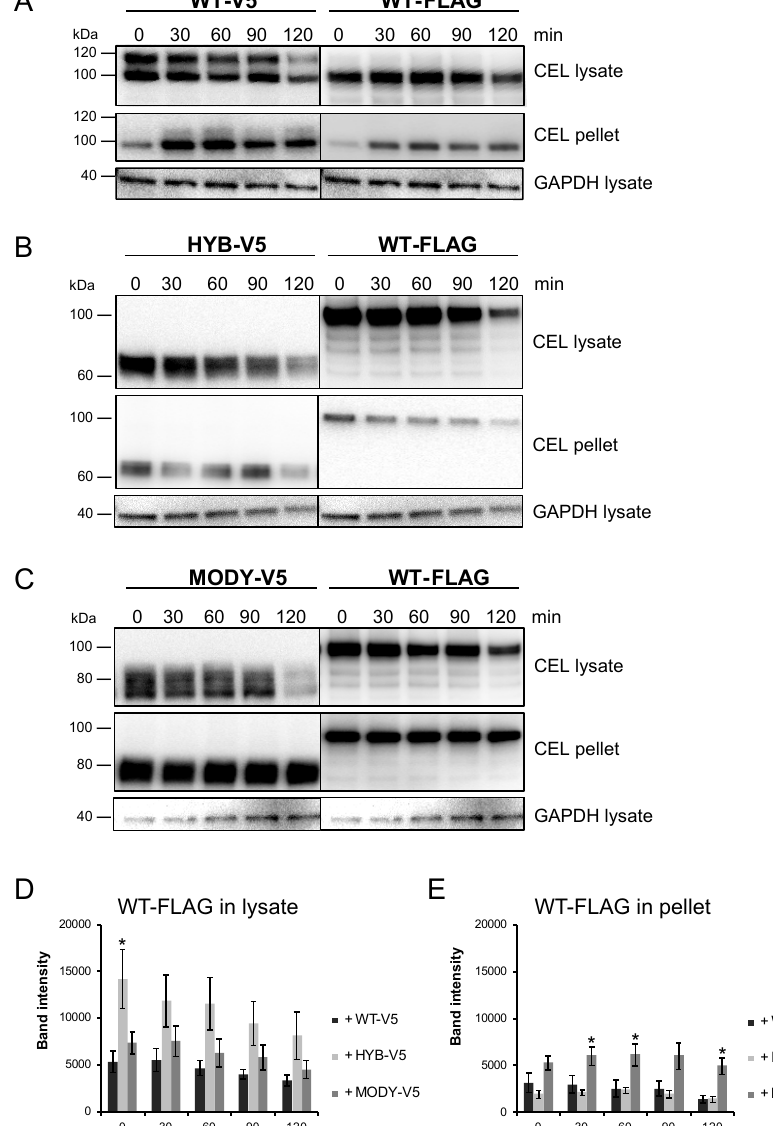
Figure 7. Cellular clearance of normal CEL protein in the presence of pathogenic CEL variants. ( A – C ): HEK293 cells were cotransfected with a FLAG-tagged CEL-WT plasmid and plasmids encoding V5-tagged CEL-WT, CEL-HYB, or CEL-MODY. After 48 h, the cells were treated with 1 µ g / mL cycloheximide for 0, 30, 60, 90, and 120 min. The lysate and pellet fractions were isolated and analyzed by anti-FLAG and anti-V5 tag-specific antibodies. GAPDH in the lysate fraction was used as loading control. ( D , E ): Bands in A–C (WT-FLAG panels) were quantified, normalized against GAPDH, and plotted as values for band intensity (arbitrary units). The experiment was repeated three times, each time with 2–3 parallels per set-up. Data are shown as mean values, the error bars representing SEM (n = 3). * denotes p < 0.05 when value is compared to the value for CEL-WT-FLAG coexpressed with